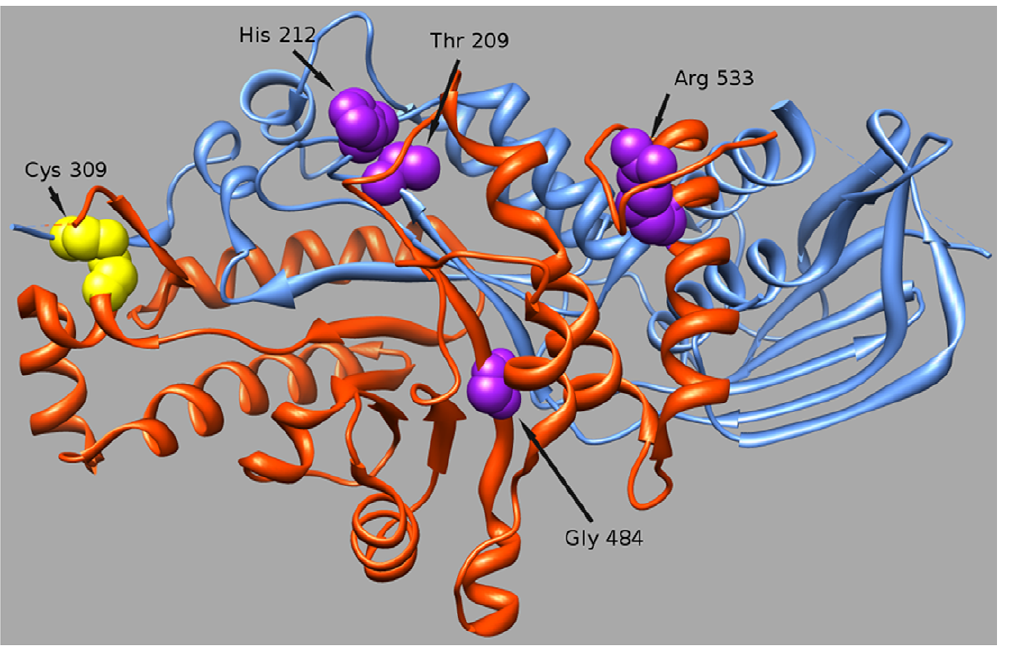
Figure 3. Location of HEXB mutations on the 3D structural model. Chains A and B are drawn as orange and blue ribbons respectively. Positions of mutations are indicated by arrows and the residues represented by spaced-filled spheres.